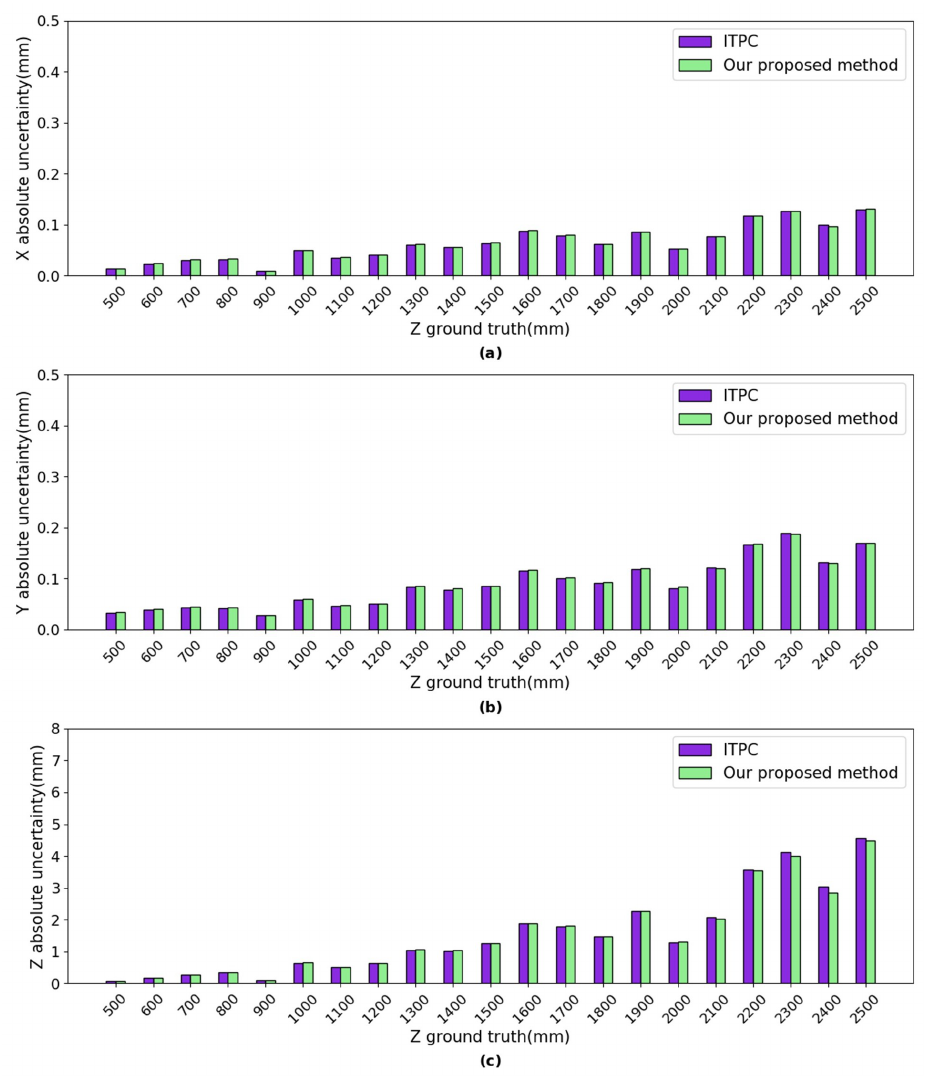
Figure 7. The uncertainties of our proposed method and ITPC method. ( a ) absolute uncertainty in X axis; ( b ) absolute uncertainty in Y axis; and, ( c ) absolute uncertainty in Z